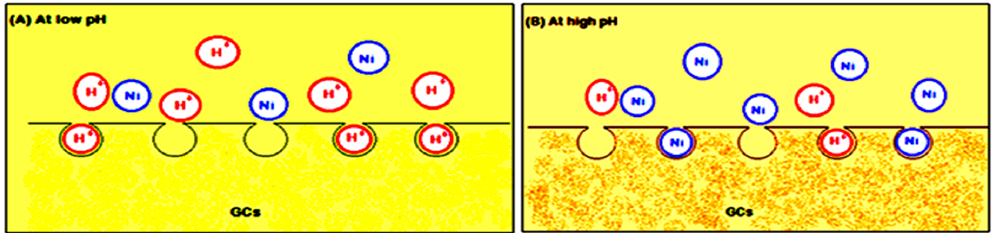
Figure 4. Metal ion uptake ( A ) at low pH and ( B ) at high pH.